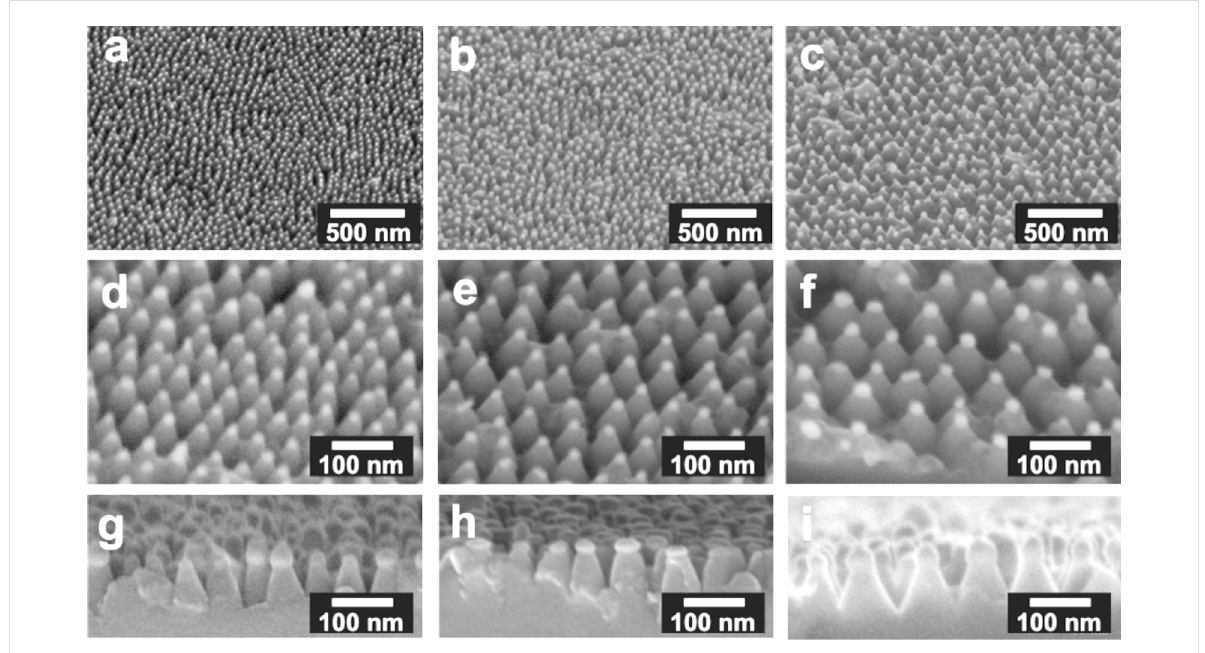
Figure 1: SEM images of the nanocone arrays with gold tips fabricated by a combination of BCML, electroless deposition, and RIE, from three different block copolymer solutions: (PS(501)- b -P2VP(323) (first column), PS(1056)- b -P2VP(495) (second column), and PS(5355)- b -P2VP(714) (third column)). The first row (a–c) shows SEM images of the nanocones taken at a 45° angle from the surface. The second row (d–f) depicts SEM images taken by using an ESB detector showing the compositional intensity differences between the gold particle and amorphous silicon oxide